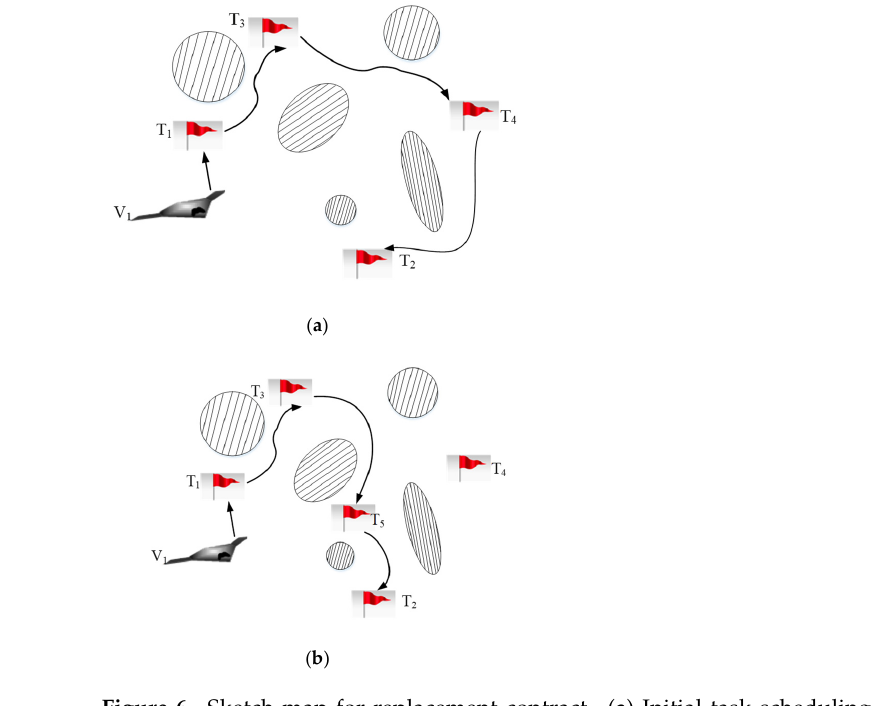
Figure 6. Sketch map for replacement contract. ( a ) Initial task scheduling scheme; ( b ) Task re- scheduling scheme.